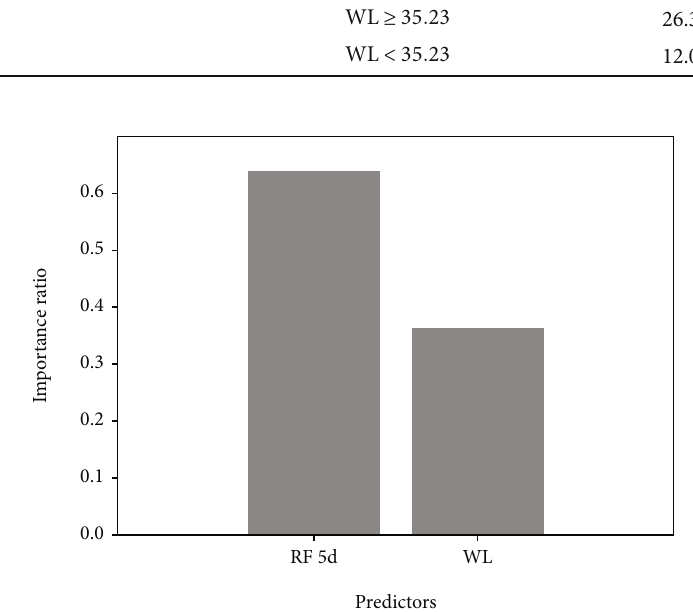
Figure 14: Predictor importance estimates for group A.